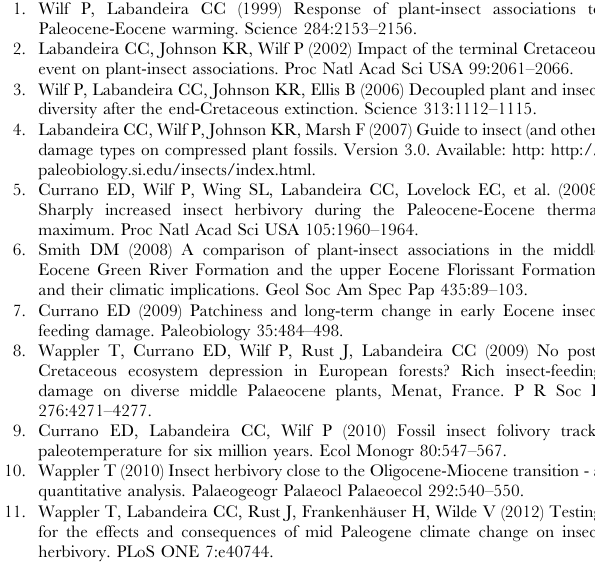
Table S5 Number and proportion of observed pairwise similarities not explained under null expectation of DTs being equally distributed across host plant